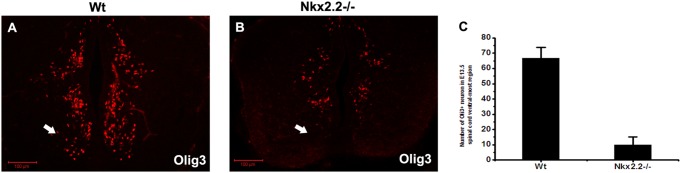
Nkx2.2 controls Olig3 expression in V3 interneurons.Transverse spinal cord sections from wild-type (A) and Nkx2.2−/− (B) embryos were subjected to immunolabeling with anti-Olig3 antibody. In E13.5 Nkx2.2 knockout mice, Olig3 expression was almost completely lost in ventral-most region of spinal cord. Arrows indicate the region in which Olig3 expression is affected. (C) The number of Olig3+ cells in the ventral-most region of E13.5 wild type and Nkx2.2−/− spinal cords. p<0.001. The dorsal part is up. Bars, 100 µm.